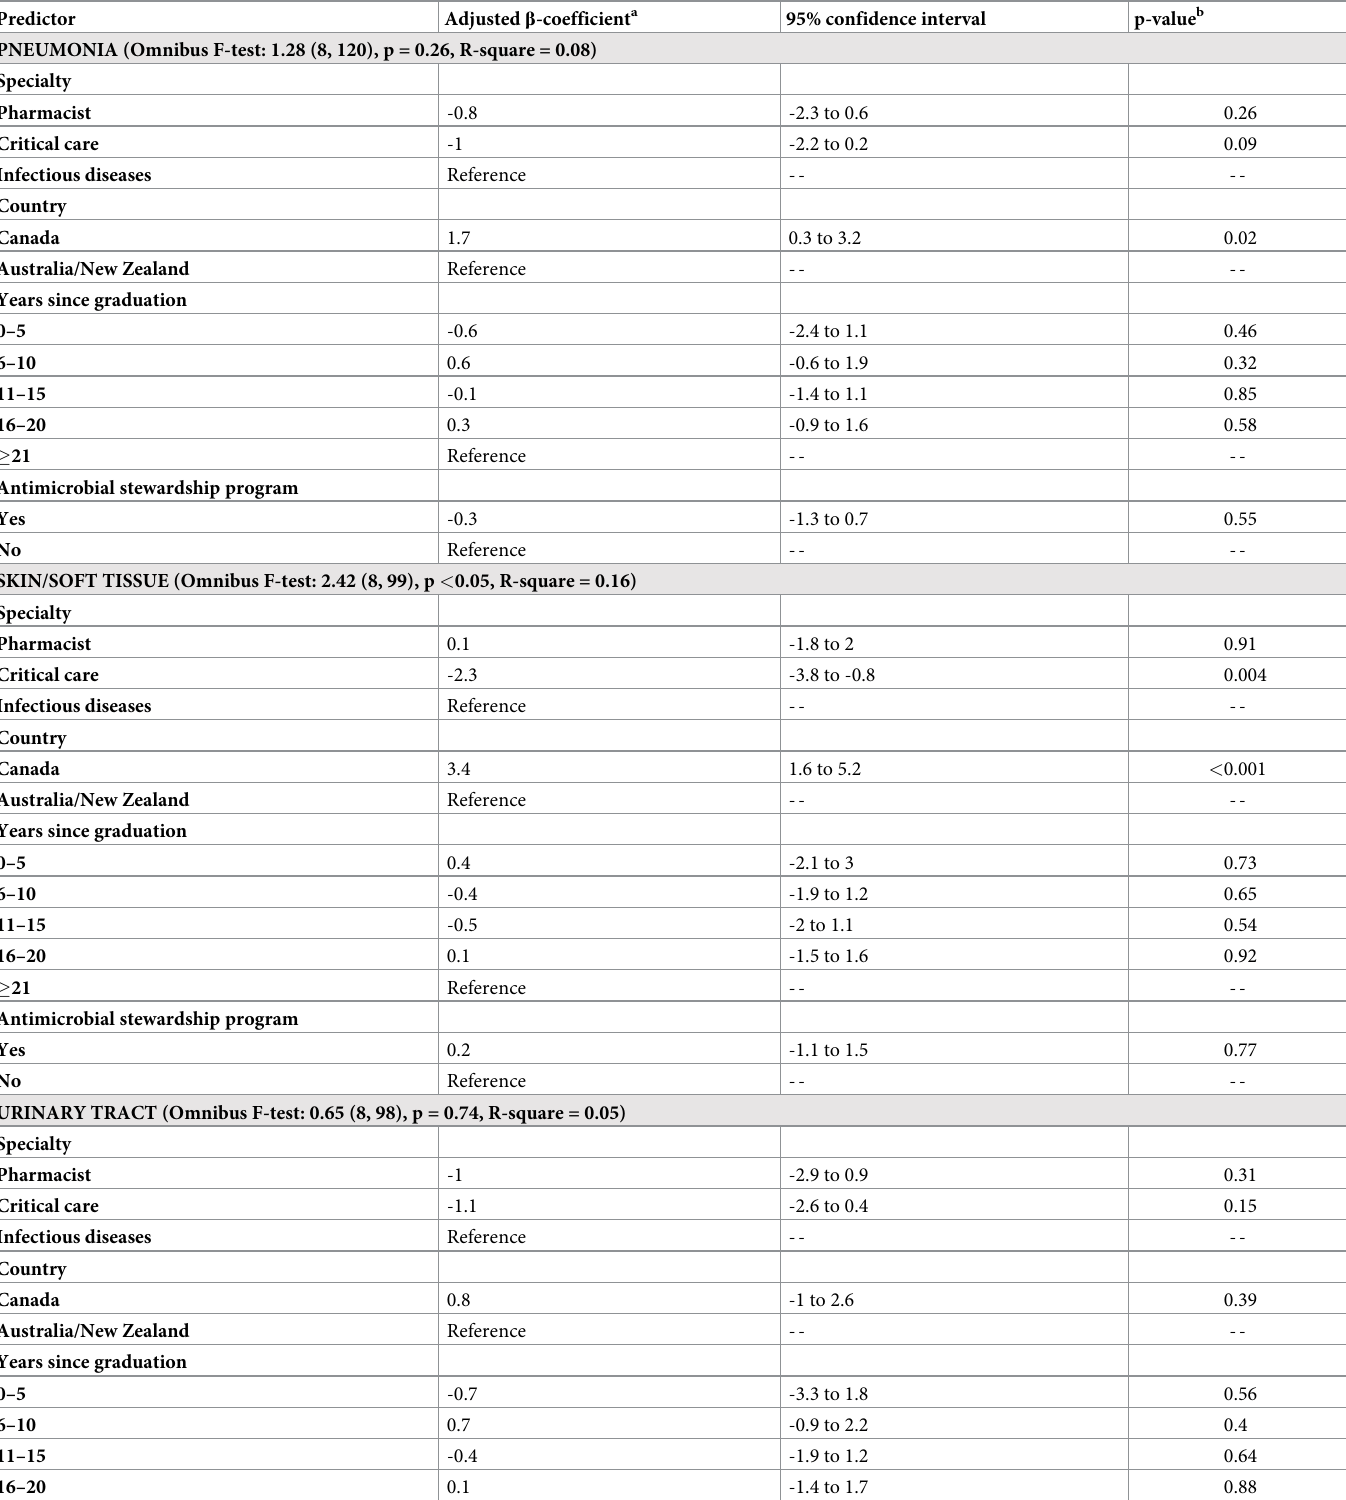
Table 3. Multivariable regression models for predictors of recommended treatment duration for different infectious